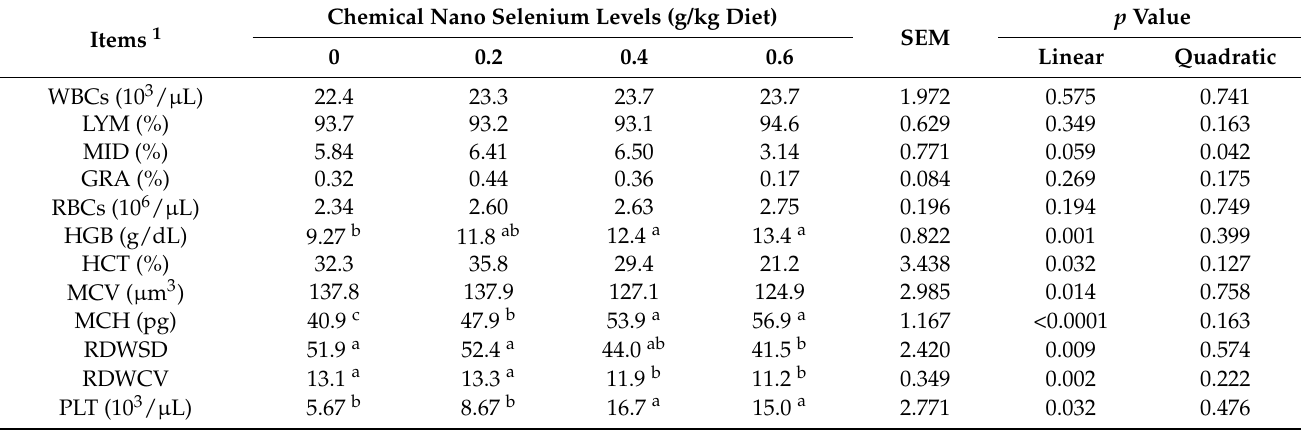
Table 6. Hematological parameters of growing Japanese quail as affected by dietary treatments.